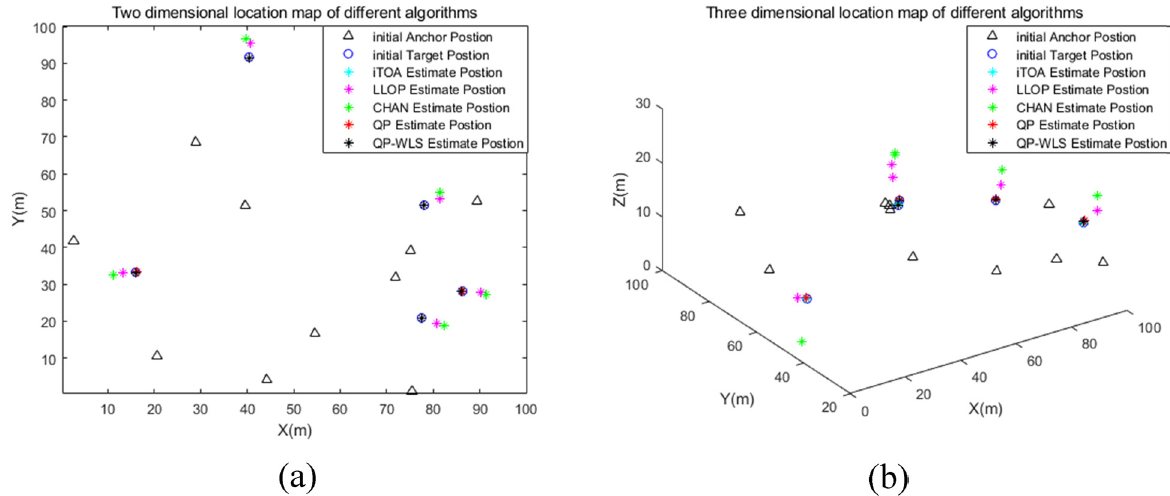
Figure 4: Multi - target localization scene. ( a ) 2D multi - target localization scene and ( b ) 3D multi - target localization scene.